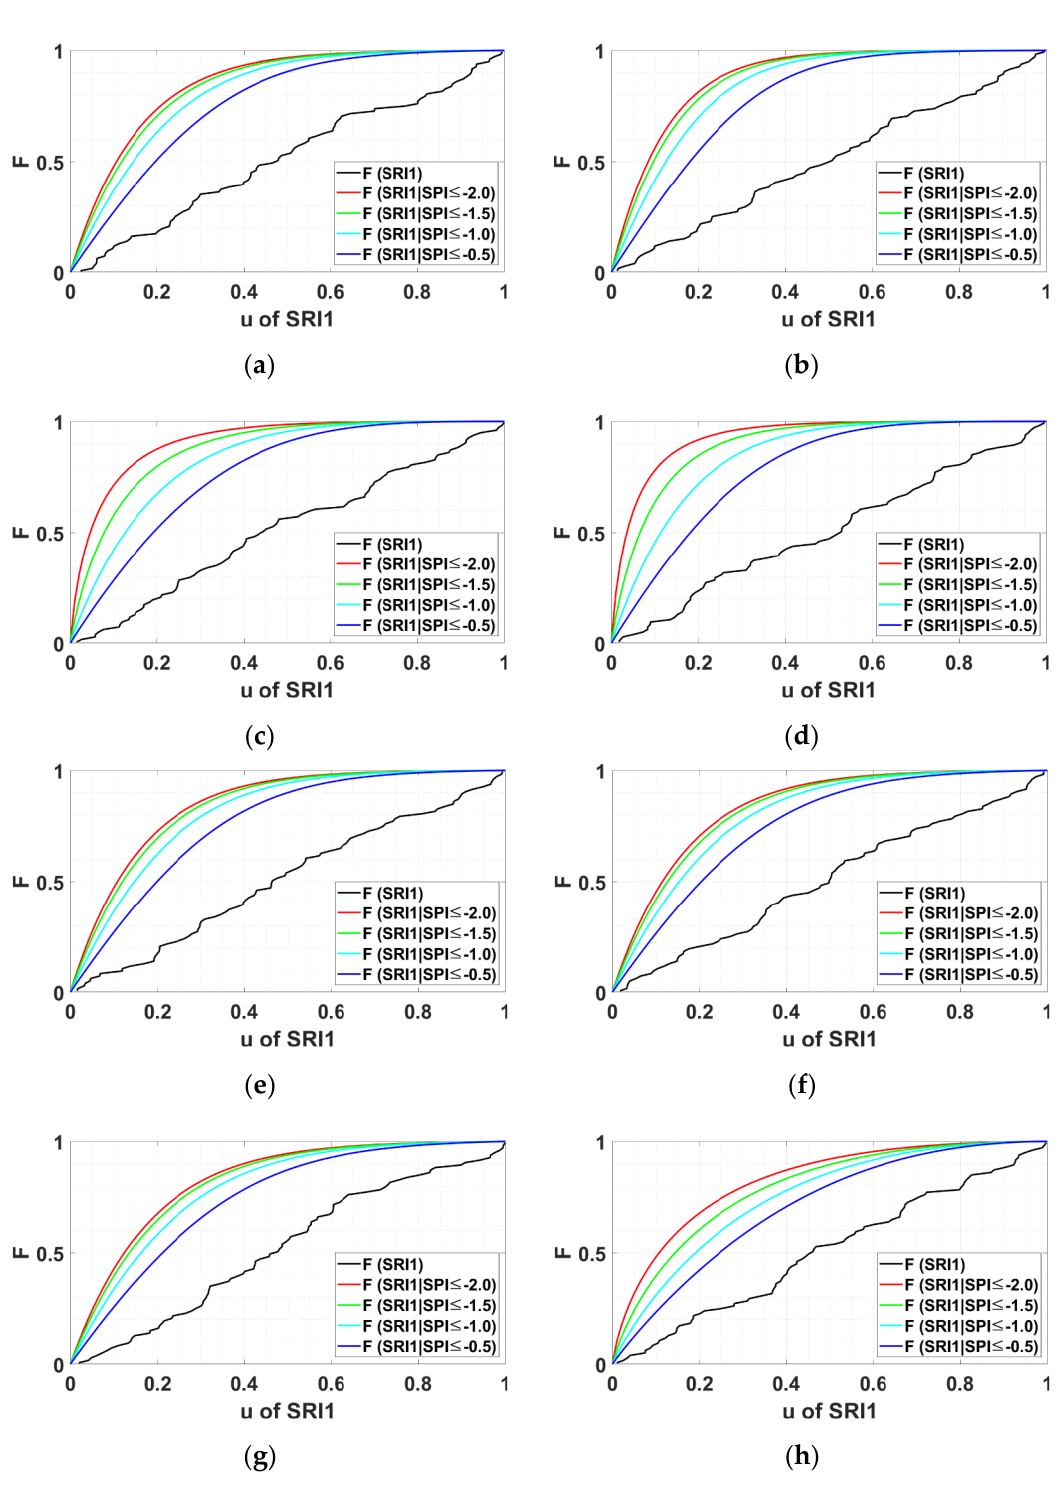
Figure 10. Conditional cumulative probabilities of SRI-1 when different severities of meteorological drought occurred (under extreme meteorological drought conditions (red), under severe meteorological drought conditions (green), under moderate meteorological drought conditions (cyan), and under mild meteorological drought conditions (blue)): ( a ) Andong Dam Basin (Spring); ( b ) Hapcheon Dam Basin (Spring); ( c ) Andong Dam Basin (Summer); ( d ) Hapcheon Dam Basin (Summer); ( e ) Andong Dam Basin (Fall); ( f ) Hapcheon Dam Basin (Fall); ( g ) Andong Dam Basin (Winter); ( h ) Hapcheon Dam Basin (Winter).